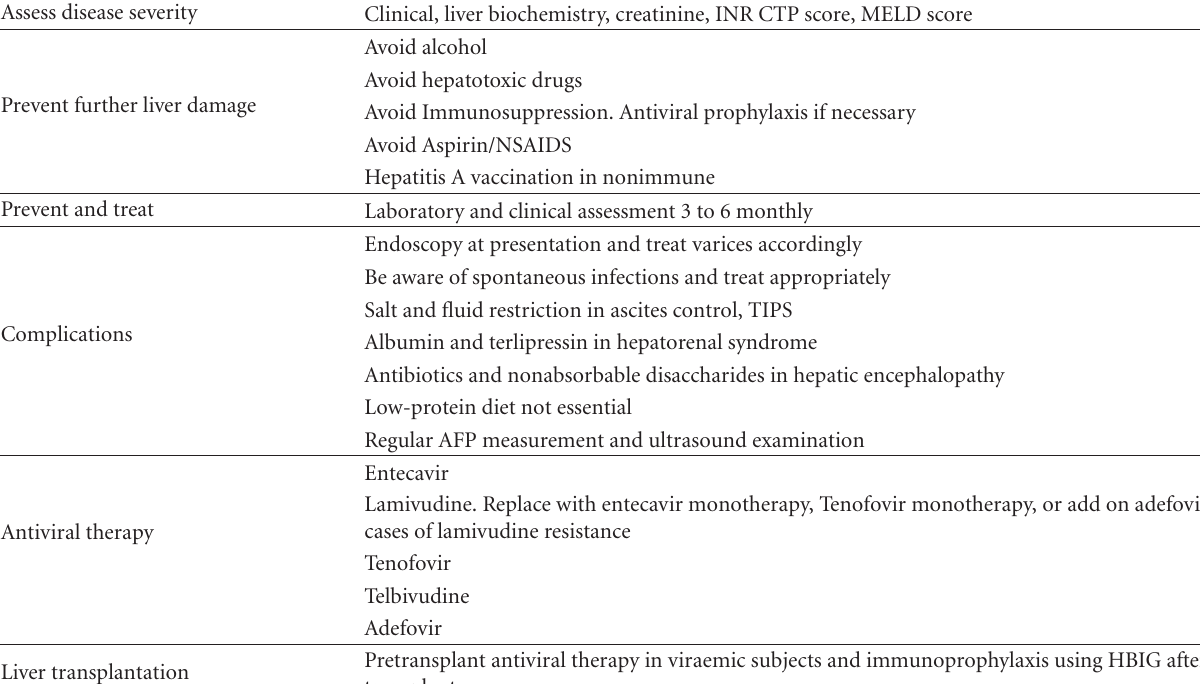
Table 2: General Recommendations in Decompensated HBV